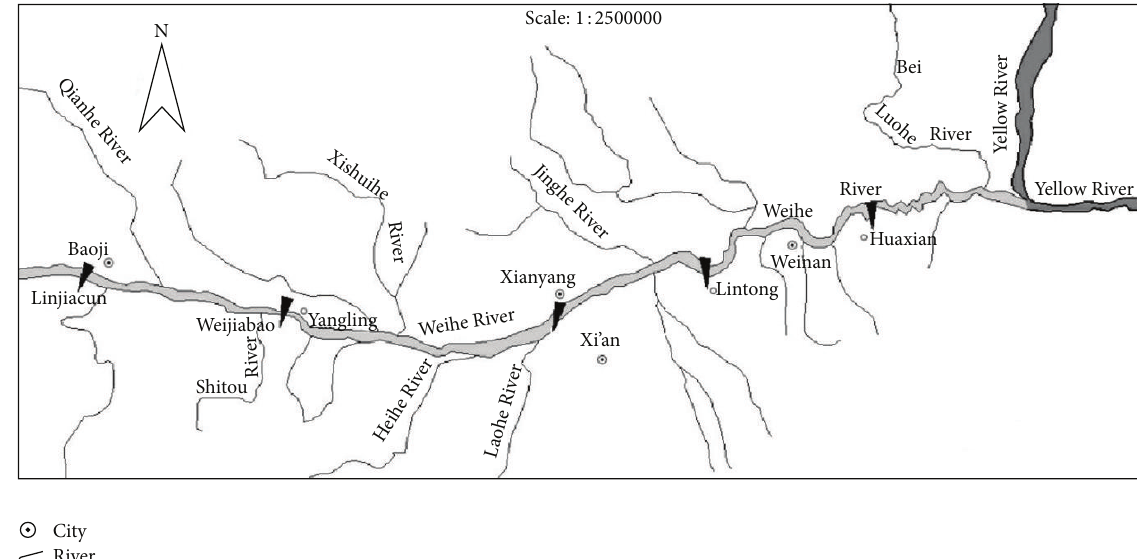
Figure 1: Study area showing hydrological gauging stations.